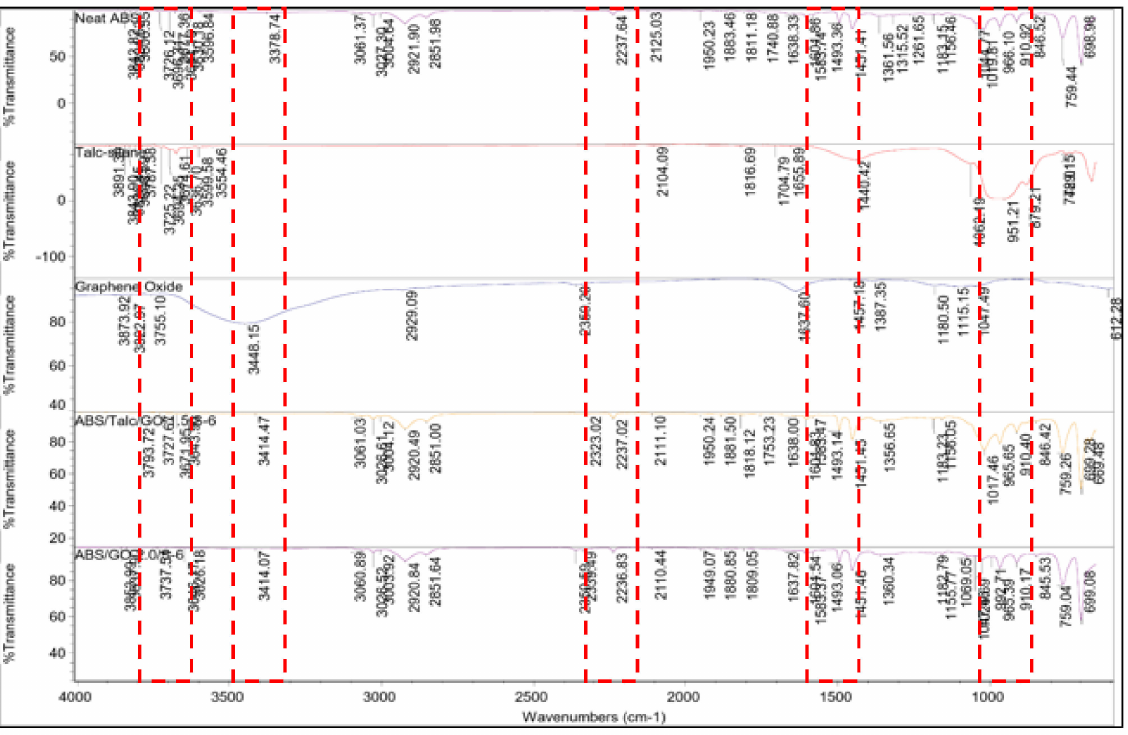
Figure 9. FTIR spectrum of ABS, talc, ABS/talc/GO − 1.5/S6, and ABS/GO − 2.0/S6. The highest spread was exhibited with compositions ABS and ABS/Go-1.0/S-6, while other compositions exhibited a much lower spread compared to these two compositions. In general, the dispersion of the data was low and acceptable. The results of 98 experiments were further analyzed using analysis of variance (ANOVA) to investigate the effect of different compositions (14 different compositions) on 6 selected responses, namely tensile strength (TS), Young’s modulus (YM), elongation at break (EB), flexural strength (FS), flexural modulus (FM), and impact strength (IS). The results of ANOVA for the selected re- sponses in Table 7 showed that different compositions significantly affect the six responses, which indicates that different compositions will result in different values of the selected responses. Significant results could be due to the dispersion of GO and the interfacial interactions with the matrix with the addition of SEBS-g-MAH. Additionally, talc at 10 wt.% acts as the reinforcing filler that increases the tensile modulus and stiffness but reduces the strain-to-break and impact strength. The reason for using all three is to balance the enhancement properties of the intended composite. The composition should improve the tensile and flexural strength, modulus, and strain-at-break, while maintaining the impact testing conducted. The data were further analyzed using Tukey’s test for multiple compar- isons to find the composition that causes the differences, which is indicated with p -values less than